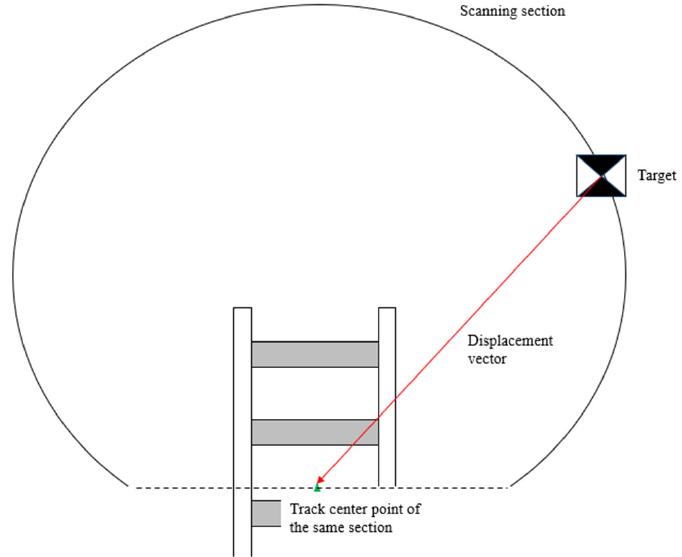
Figure 14. Displacement vector from the center of the target to the center of the track in the same section.